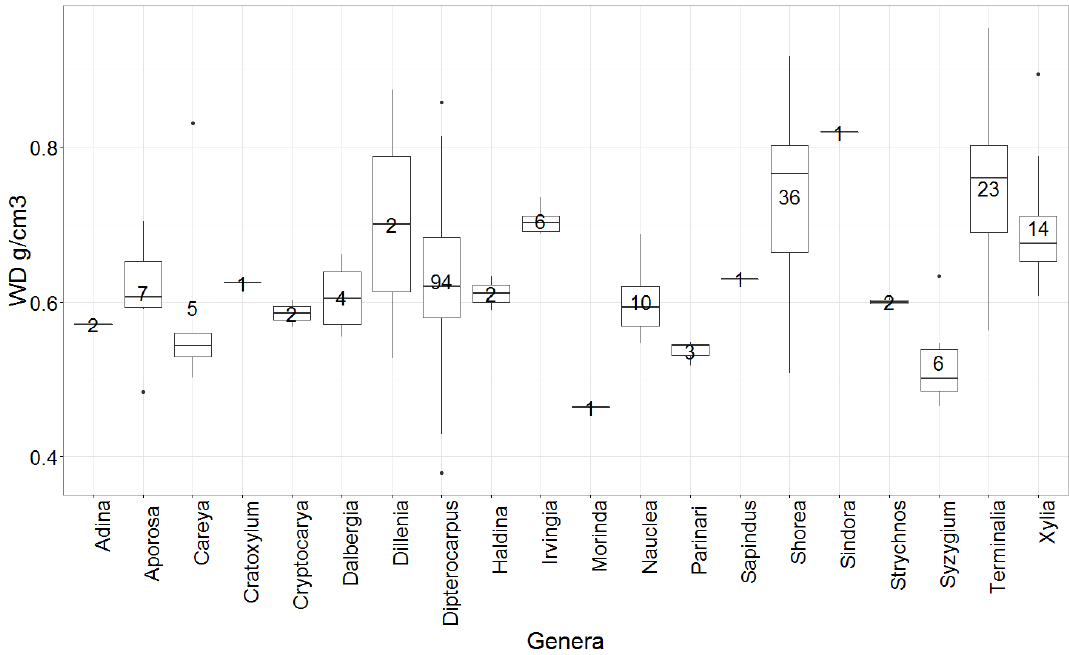
Figure 3. Box plot of WD by sampled genera in alphabetical order. Numbers inside the boxplots represent the sample size in that genus.